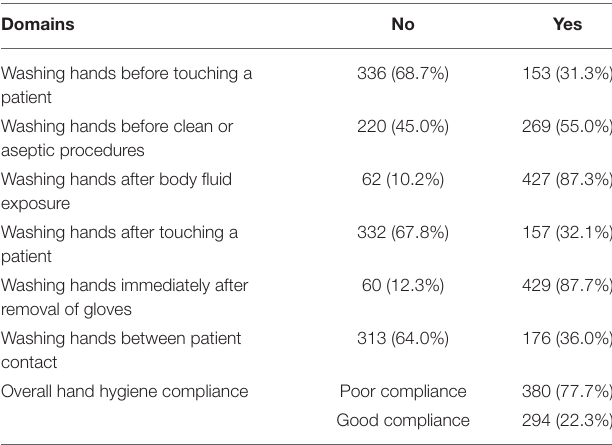
TABLE 5 | Hand hygiene domains among healthcare workers toward COVID-19 in public hospitals of South Wollo Zone, Northeastern Ethiopia, 2021.